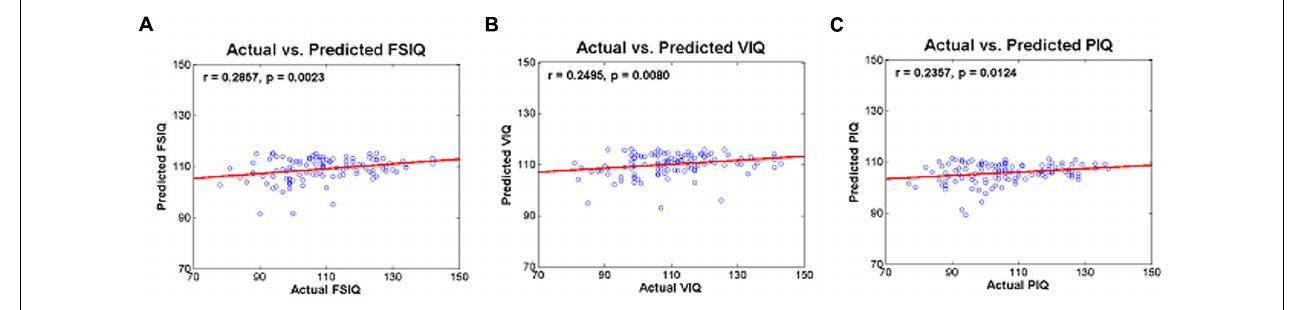
FIGURE 3 | Actual and predicted (A) FSIQ using IC 5, (B) VIQ using IC 5, and (C) PIQ using IC